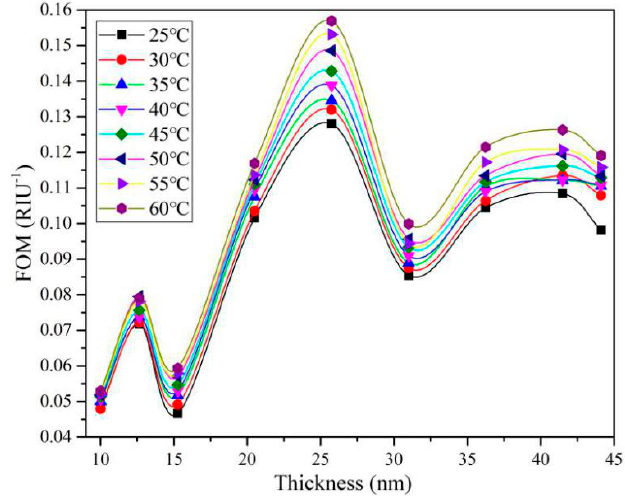
Figure 8. Gold film thickness dependence of FOM during temperature measurement.